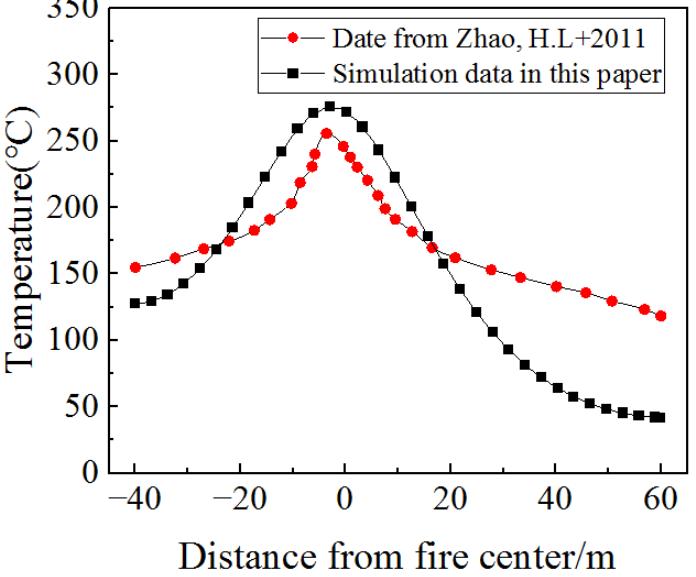
Figure 11. Comparison of the temperature range in the tunnel vault along the longitudinal direction between the reference [38] and the model in this paper.